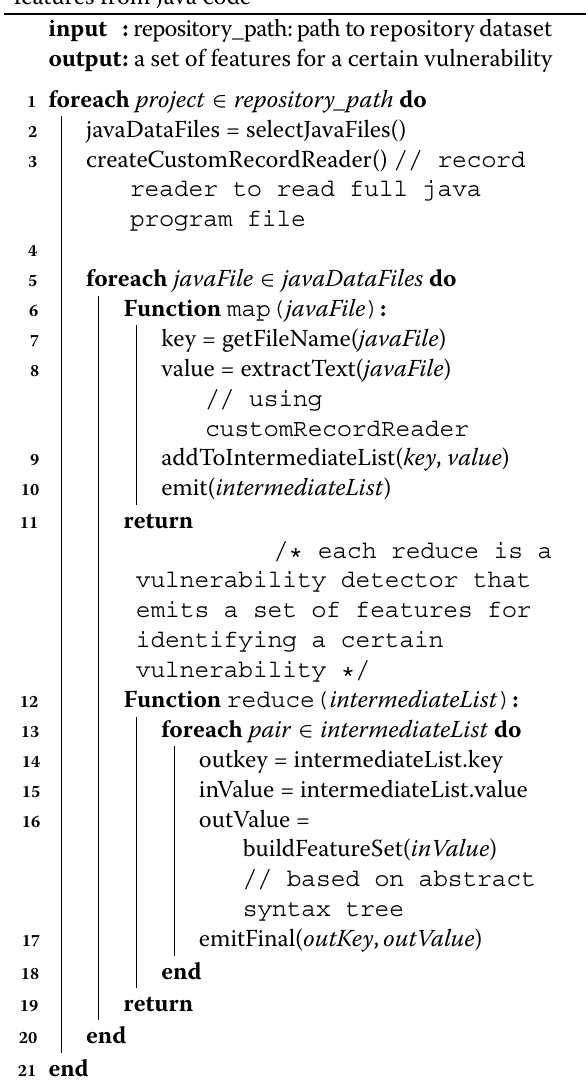
Algorithm 1: MapReduce algorithm for mining features from Java